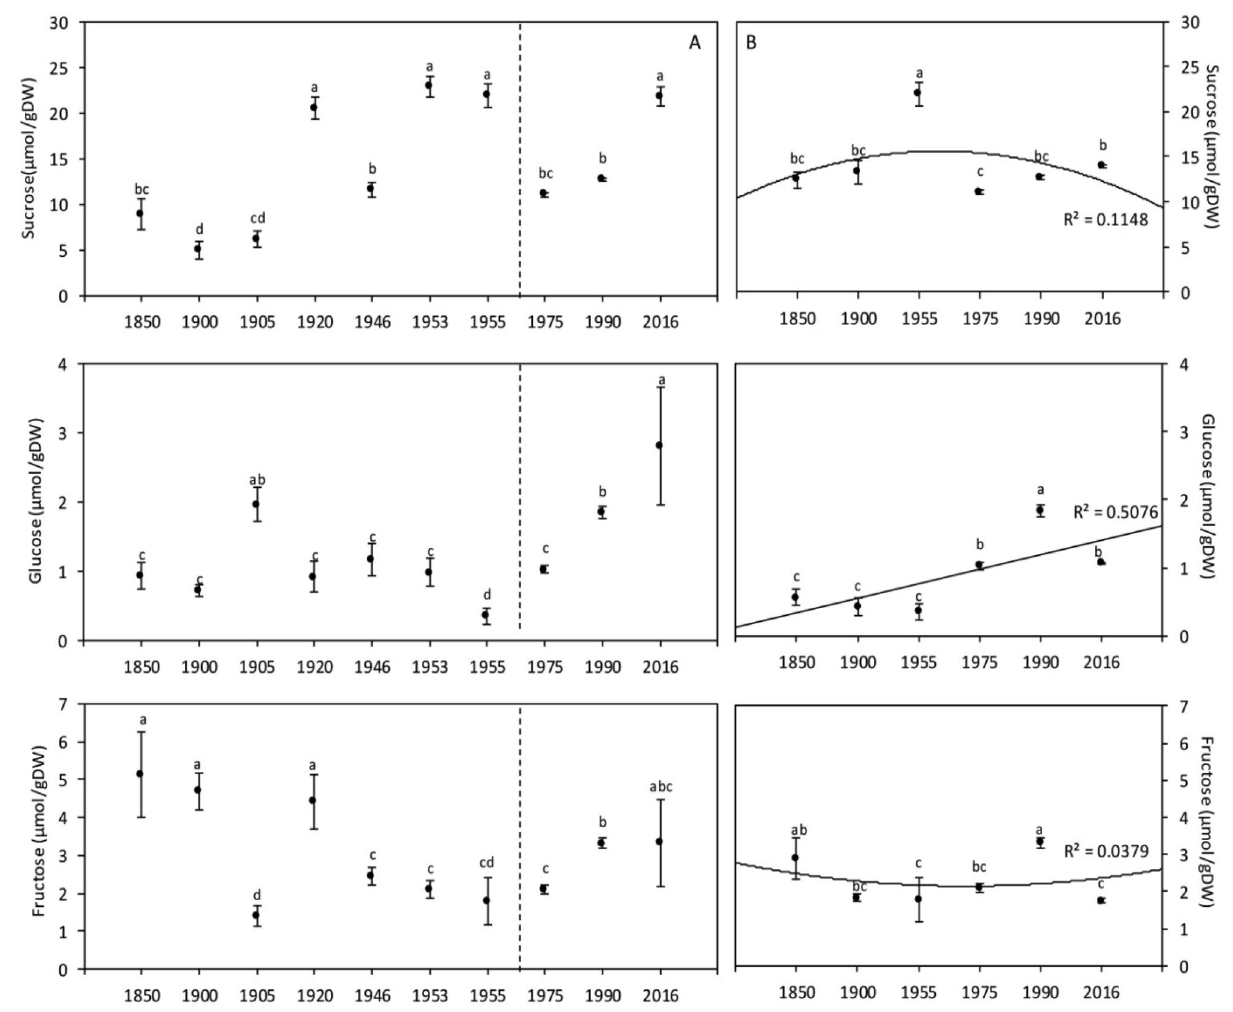
Figure 4. Wheat grain soluble sugar (sucrose, glucose and fructose) concentration of global ( A , C , F ) and Broadbalk experiment ( B , D , G ) samples. The dashed line corresponds to the separation between the [1850– 1955] and [1975–2016] periods, based on the increase of [CO 2 ]. Data are means ± standard errors (n = 3–14). The same letters indicate no statistically significant differences among years (Fisher’s LSD, p ≥ 0.05).